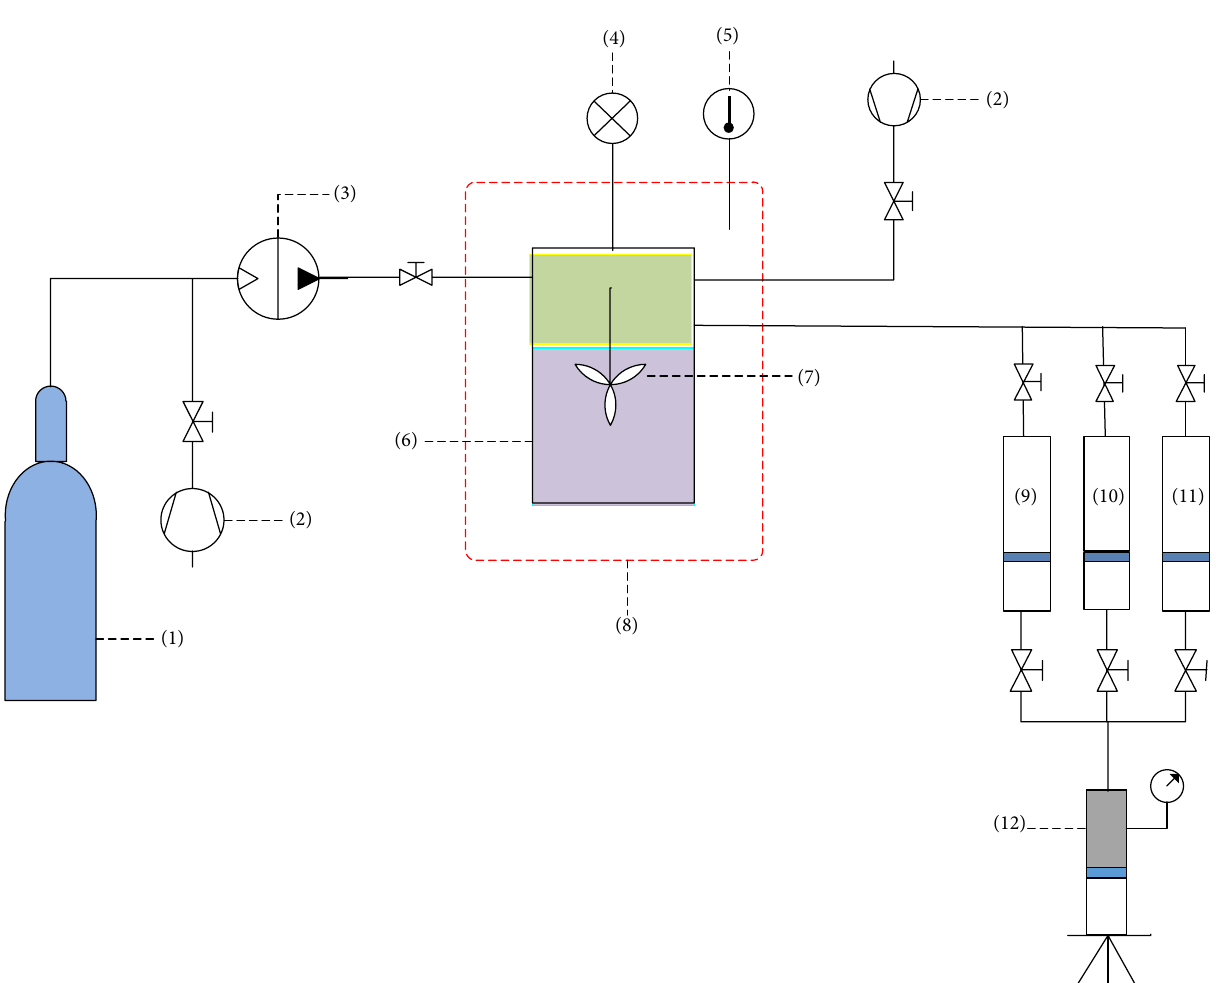
Figure 1: Schematic diagram of the in situ generated CO 2 apparatus. ( 1 ) Gas cylinder, ( 2 ) vacuum pump, ( 3 ) pressure amplifier, ( 4 ) pressure gauge, ( 5 ) temperature transducer, ( 6 ) reaction vessel, ( 7 ) magnetic stirrer, ( 8 ) thermostatic air bath, ( 9 ) Na 2 CO 3 solution, ( 10 ) NaHCO 3 solution, ( 11 ) compound acid, and ( 12 ) pump.